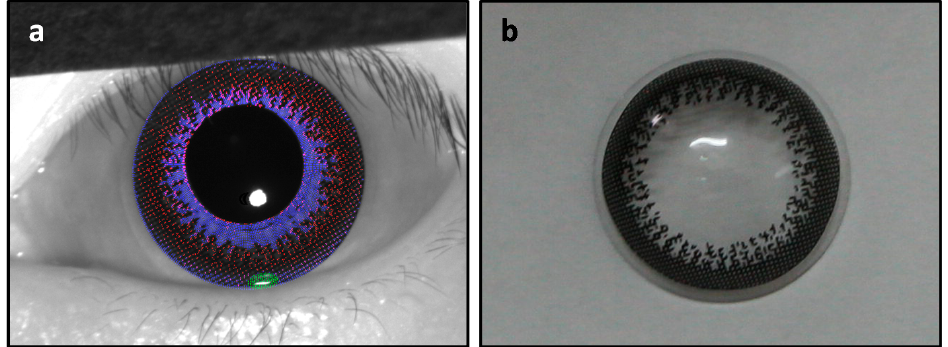
Figure 7. ( a ) The estimated CCL (colored in red) and remaining natural iris pattern (colored in blue) were visualized for the comparison purpose, where the annular dot pattern at the outer boundary were in close agreement with ( b ) ground truth CCL picture.